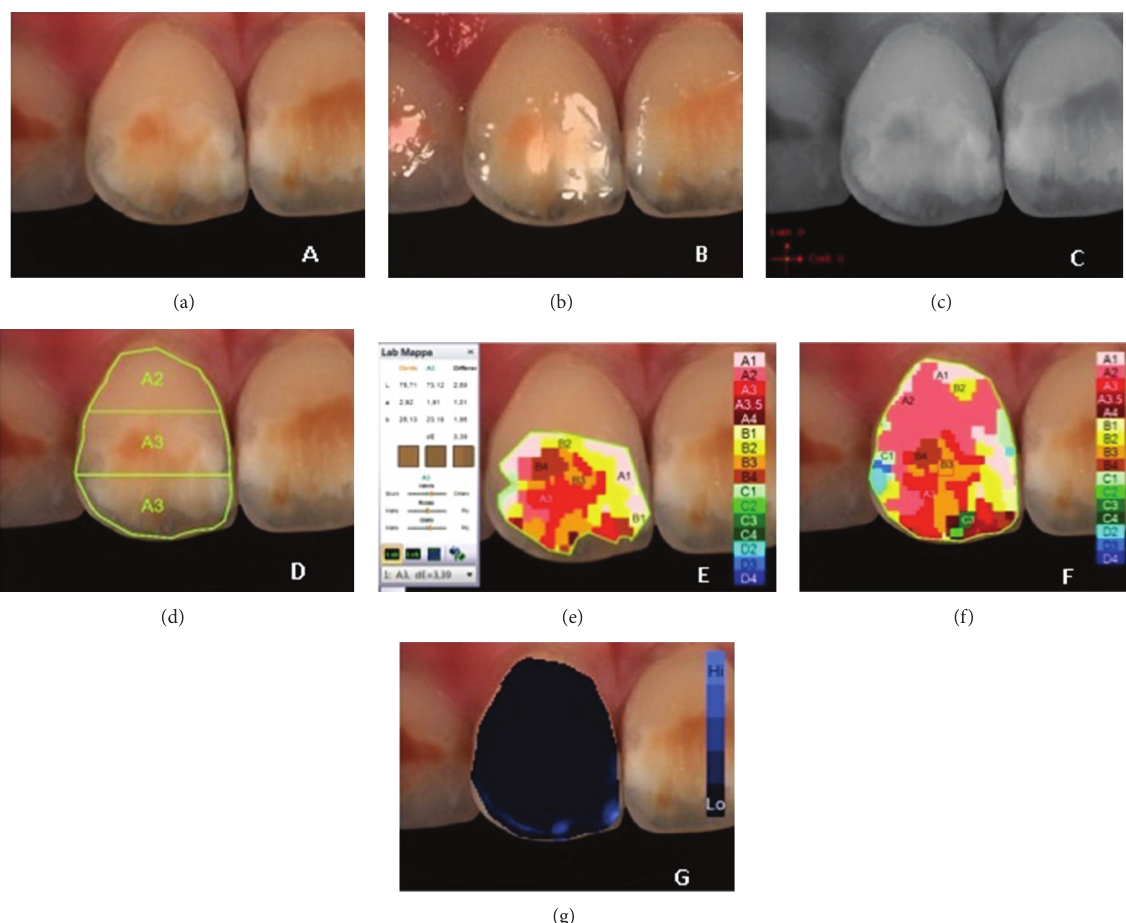
Figure3:Exampleof 𝐿 ∗ 𝑎 ∗ 𝑏 ∗ measurementsofdemarcatedopacityonuppercentralrightincisor:(a)polarizedimage;(b)glossmodeallowing the identification of “pure enamel zones”; (c) contrast image; (d) evaluation of the three equal zones along the median axis: gingival, central, and incisal; (e) colour distribution and detailed mapping of the defect surface; (f) overall detailed mapping; (g)